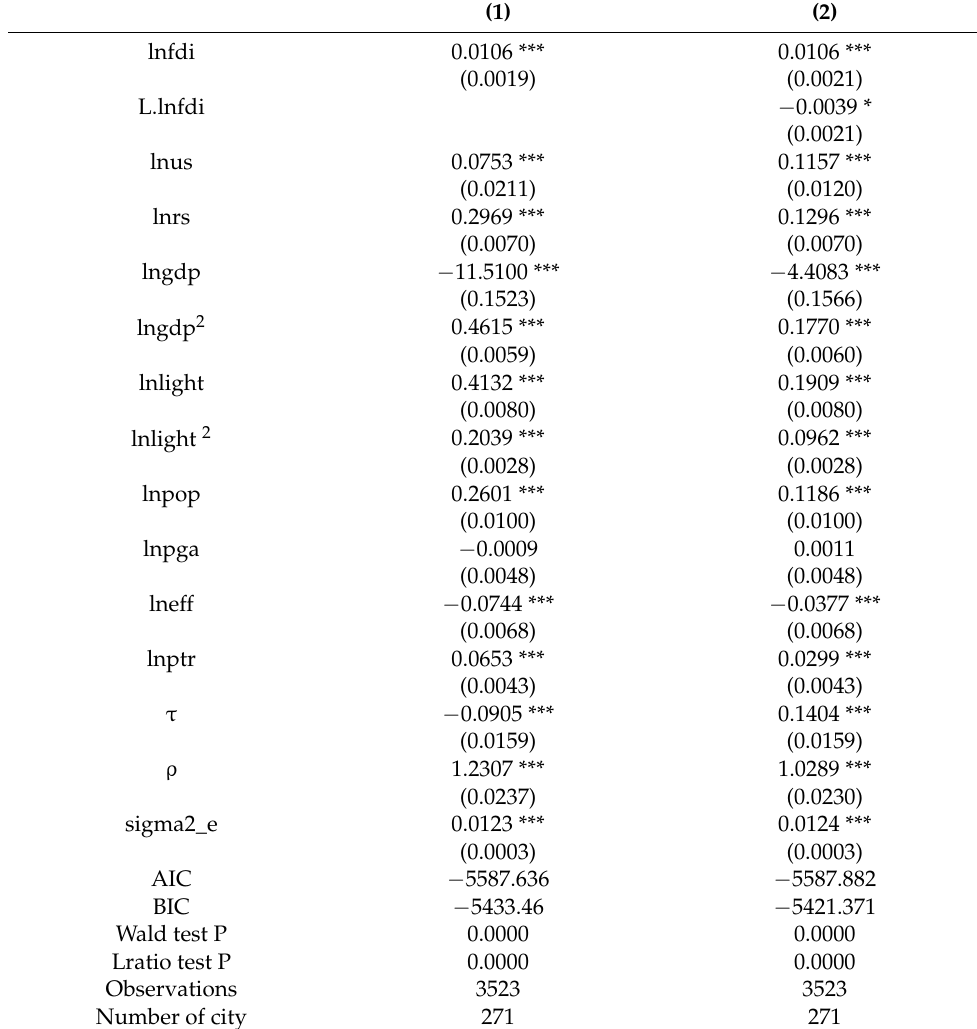
Table 7. Robustness